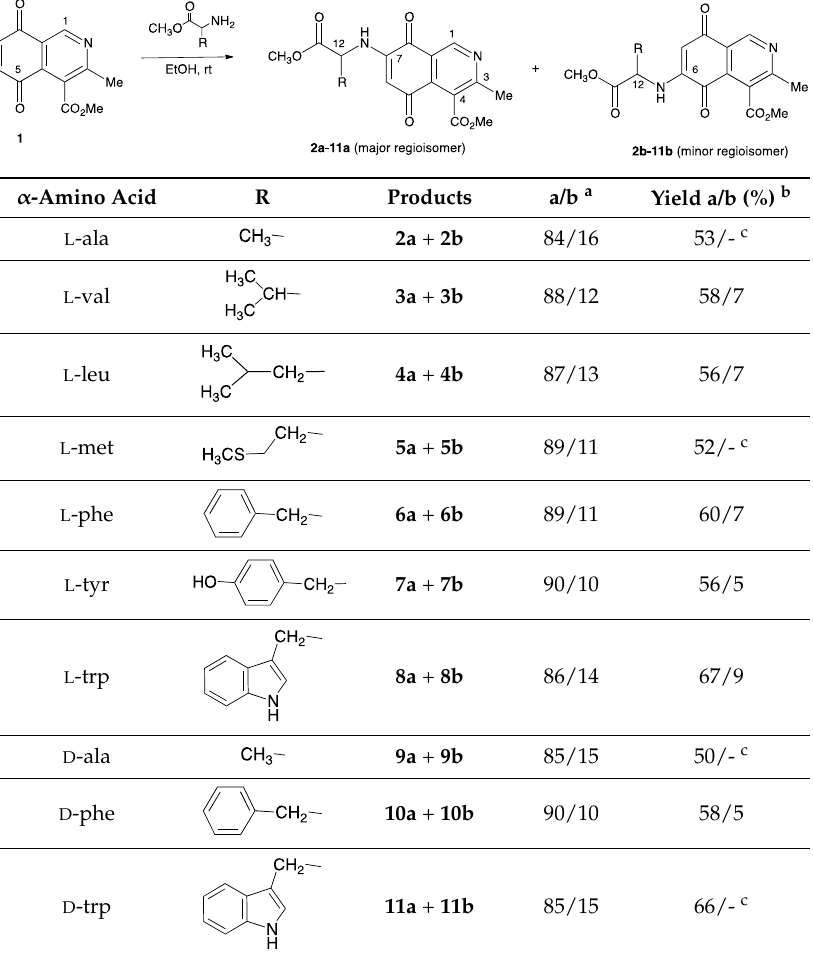
Table 1. Reaction of isoquinolinequinone 1 with α -amino acid methyl esters.